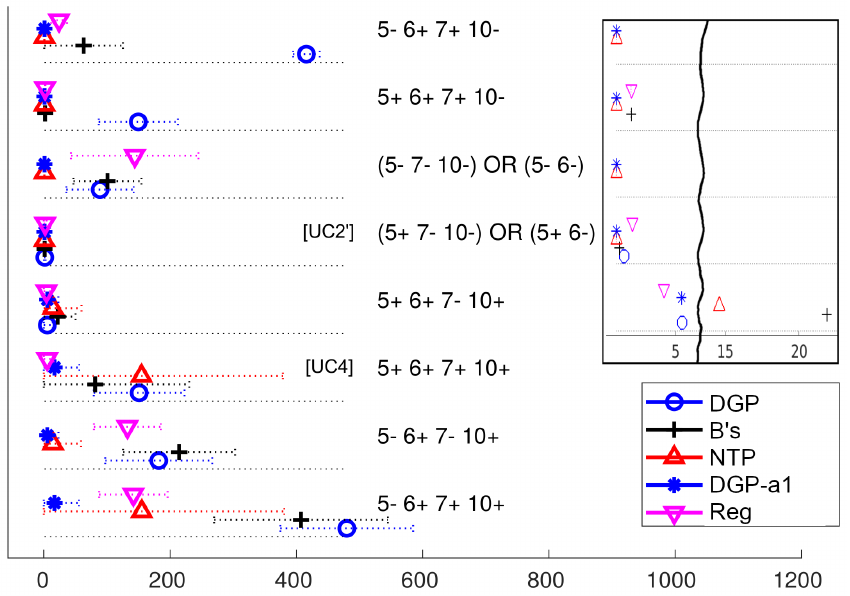
Figure A2. Eight distinctive behaviours have been found in the scenarios for M 2 ( β R − entry ) when α R = 1. Axes 3 and 4 must be at the same extreme position to assure α R = 1. Top-right) Zoom in on the average values at the left-most part of the first five